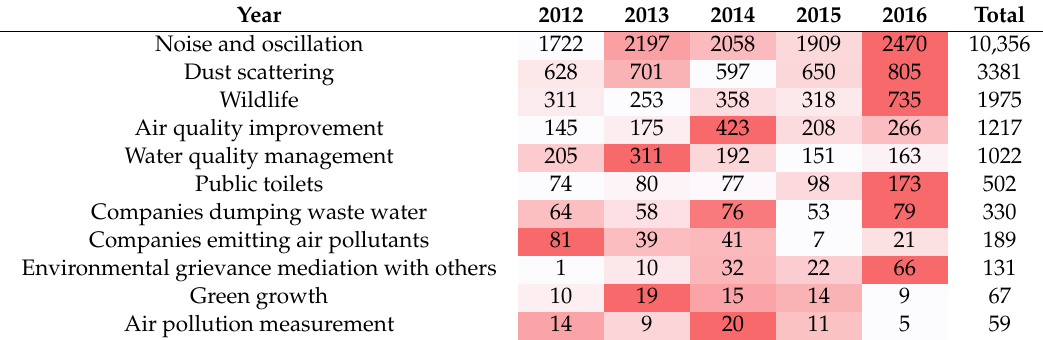
Table 2. Basic statistics of public complaints in Namyangju (the darker the cell is, the more